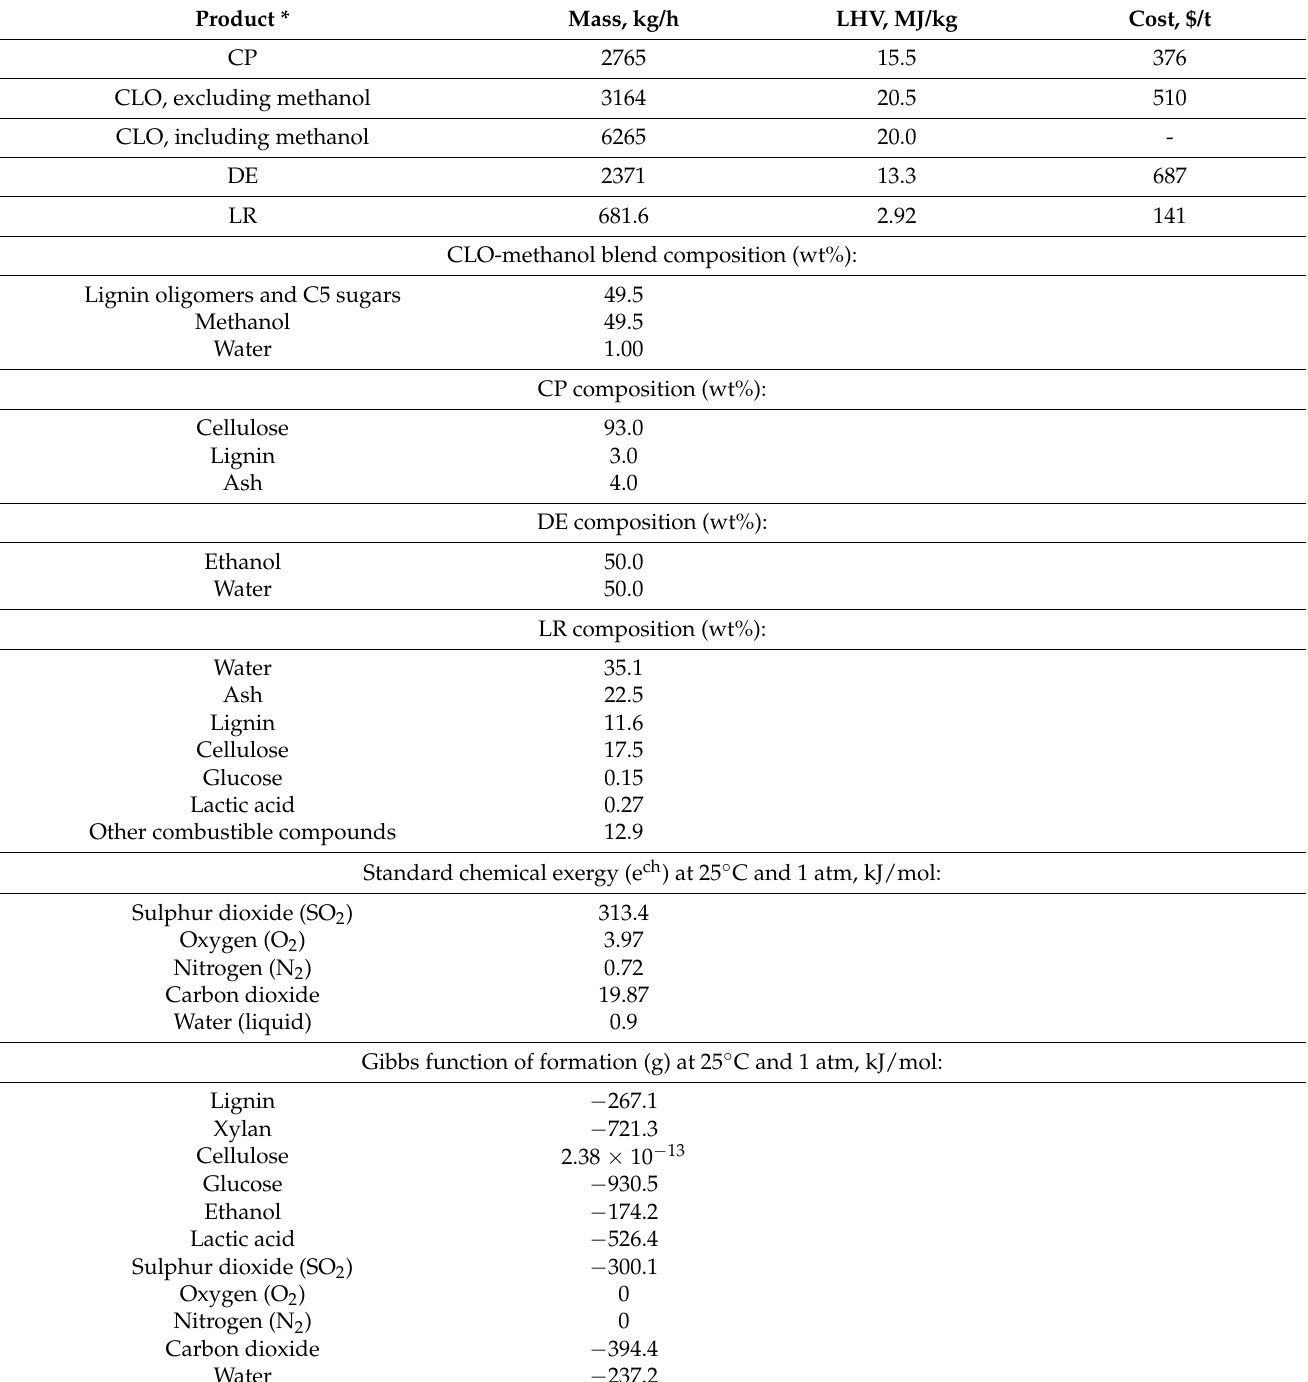
Table A2. Inputs to allocation